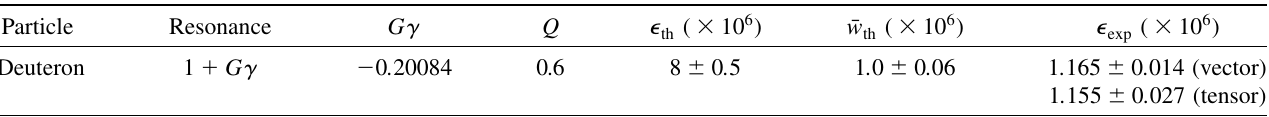
TABLE I. Comparison of experimental and theoretical resonance strengths (including the spin response function) for the spin flipping of stored polarized deuteron